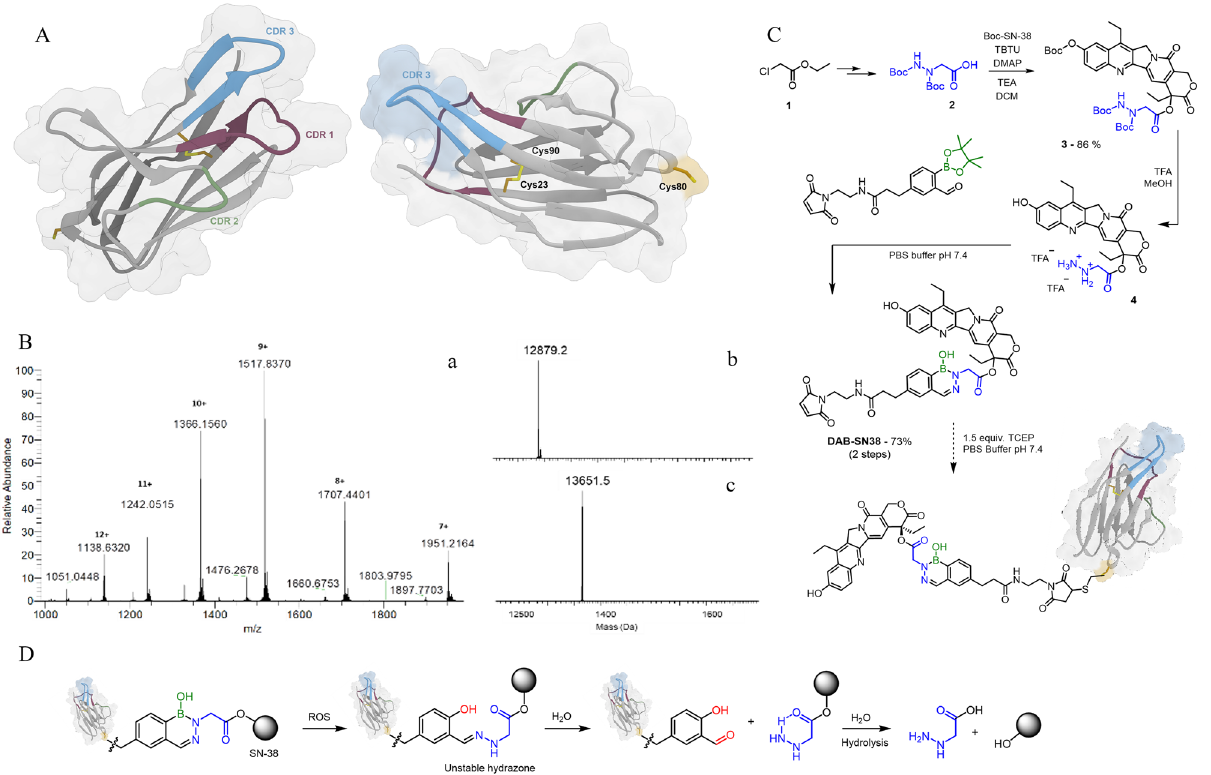
Figure 6. Development of C5-DAB-SN-38 ADC. ( A ) Ribbon representation of C5 sdAb’s predicted 3D structure. The complementarity-determining regions (CDRs) domains have been highlighted in purple (CDR1), green (CDR2) and blue (CDR3). The side chain atoms are shown in stick representation and colored in yellow. The van der Waals surface is depicted in transparent coloring. The surfaces of CDR3 and Cys80 have been highlighted with blue and yellow coloring, respectively. CDR and amino acid numbering were done according to Kabat et al. 54 ( B ) High-resolution mass spectra of conjugate C5-DAB-SN-38. To a PBS pH 7.4 solution containing C5 (10 µM) and TCEP (1.5 equiv., 3.5 mM), DAB (20 equiv., 9 mM, DMSO) was added ◦ and the solution was mixed during 1.5 h at 25 C. The expected conjugate was evaluated after 1.5 h by